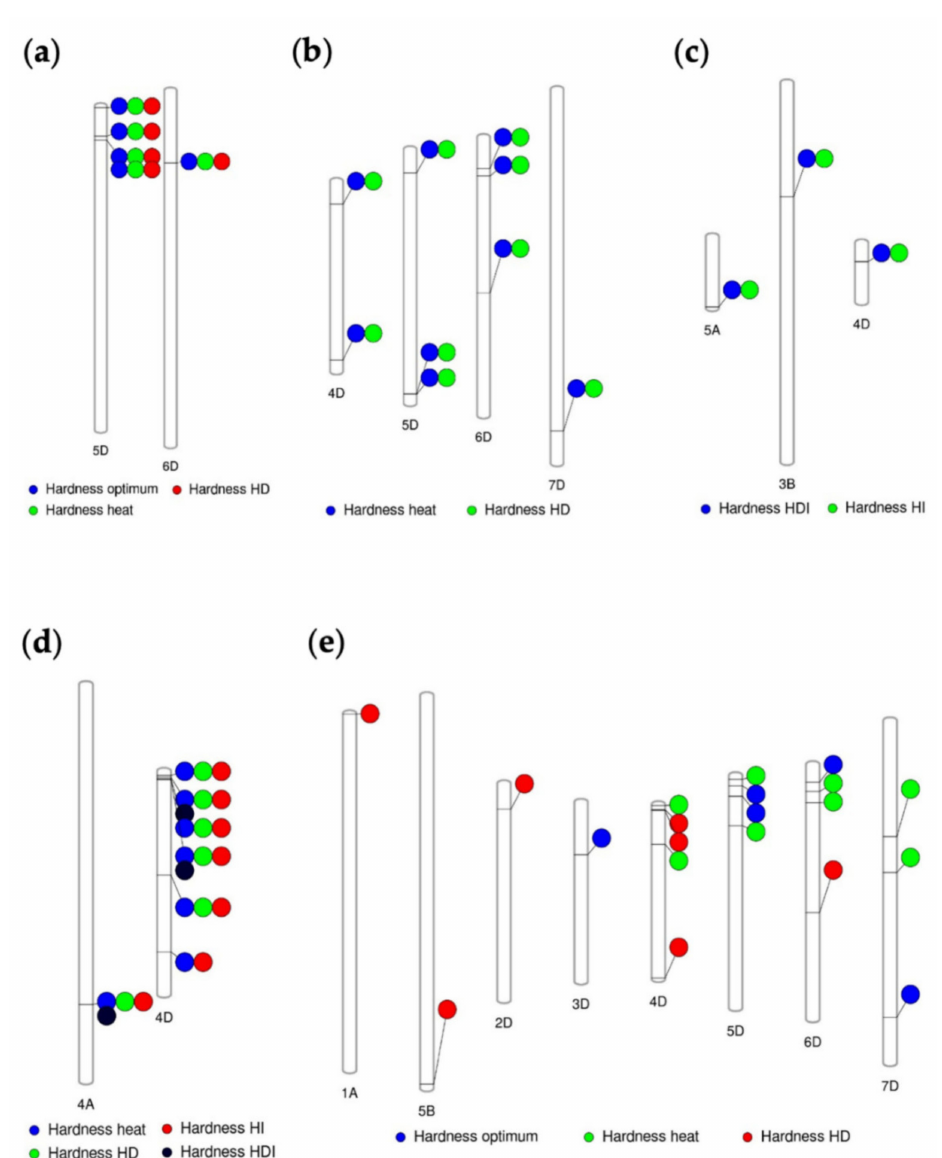
Figure 6. Significant marker trait associations (MTAs) for hardness that were ( a ) Stable MTAs under all conditions, ( b ) Significant markers associated with stress environment heat and HD, ( c ) Significant marker associated with hardness stress index HI and HDI , ( d ) Significant markers associated with stress condition for both hardness and hardness indexes ( e ) Significant markers associated with certain